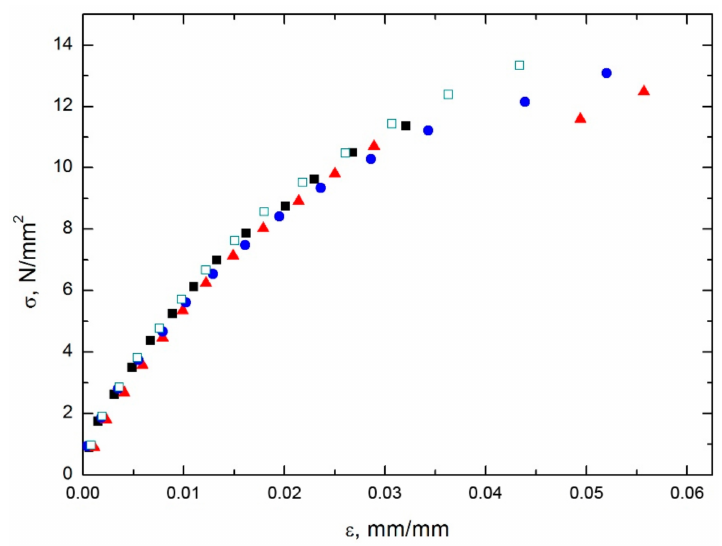
Figure 5. Results of tensile tests on the neat